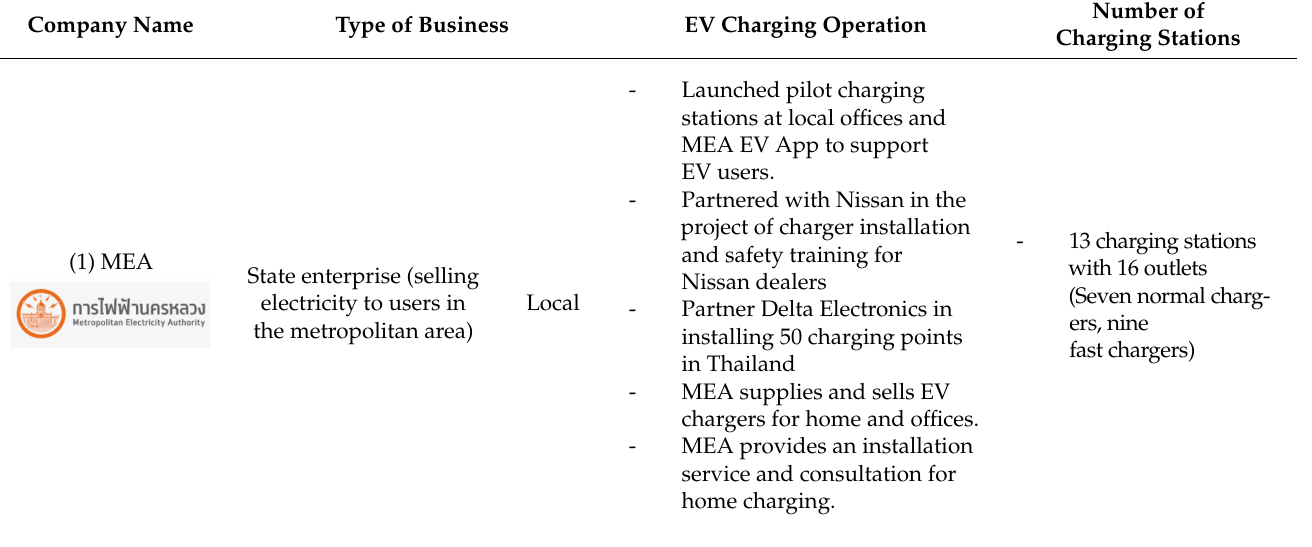
Table 5. EV charging operations of electricity state